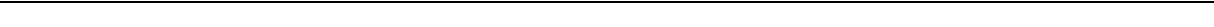
Supplementary Fig. 2. ( b ) Arp53D expression in flight muscle is de-repressed in Dp knockdown. RT–qPCR, mean ± s.e.m., N ¼ 3 samples per genotype, Mann–Whitney test, * P o 0.05. ( c , d ) Muscle size is reduced in Dp-depleted muscles. Transverse sections of pharate thoraces (ventral to the bottom). Each hemithorax contains six DLM (white asterisks, left panel). Scale bar, 50 m m. ( c ) Paraffin-embedded sections stained with haematoxylin and eosin. DLM4 (dashed black boxes) magnified at the bottom panel. Black arrowheads point the aggregates/clumps. Quantification of total number of DLMs per hemithorax, mean ± s.d., N ¼ 21, 16 per genotype, Mann–Whitney test, P 4 0.05. ( d ) Sections stained with Phalloidin and 4,6-diamidino-2-phenylindole (DAPI; top panel). DLM 4 stained with Phalloidin (middle panel), b -PS integrin to mark the plasma membrane and DAPI (bottom panel). Cluster of myofibrils is outlined (yellow dashed line). Quantification of DLM4 cross-section area per fly (mm 2 ). Area of myofibril clusters, total number of myofibril cluster, total number of myofibrils per cluster, myofibril density per cluster area ( m m 2 ), total number of nuclei and density of nuclei per DLM4 area ( m m 2 ) are quantified per DLM4, mean ± s.e.m., N ¼ 8 per genotype, t -test with Welch’s correction, ** P o 0.01; *** P o 0.001. Three independent experiments. ( e